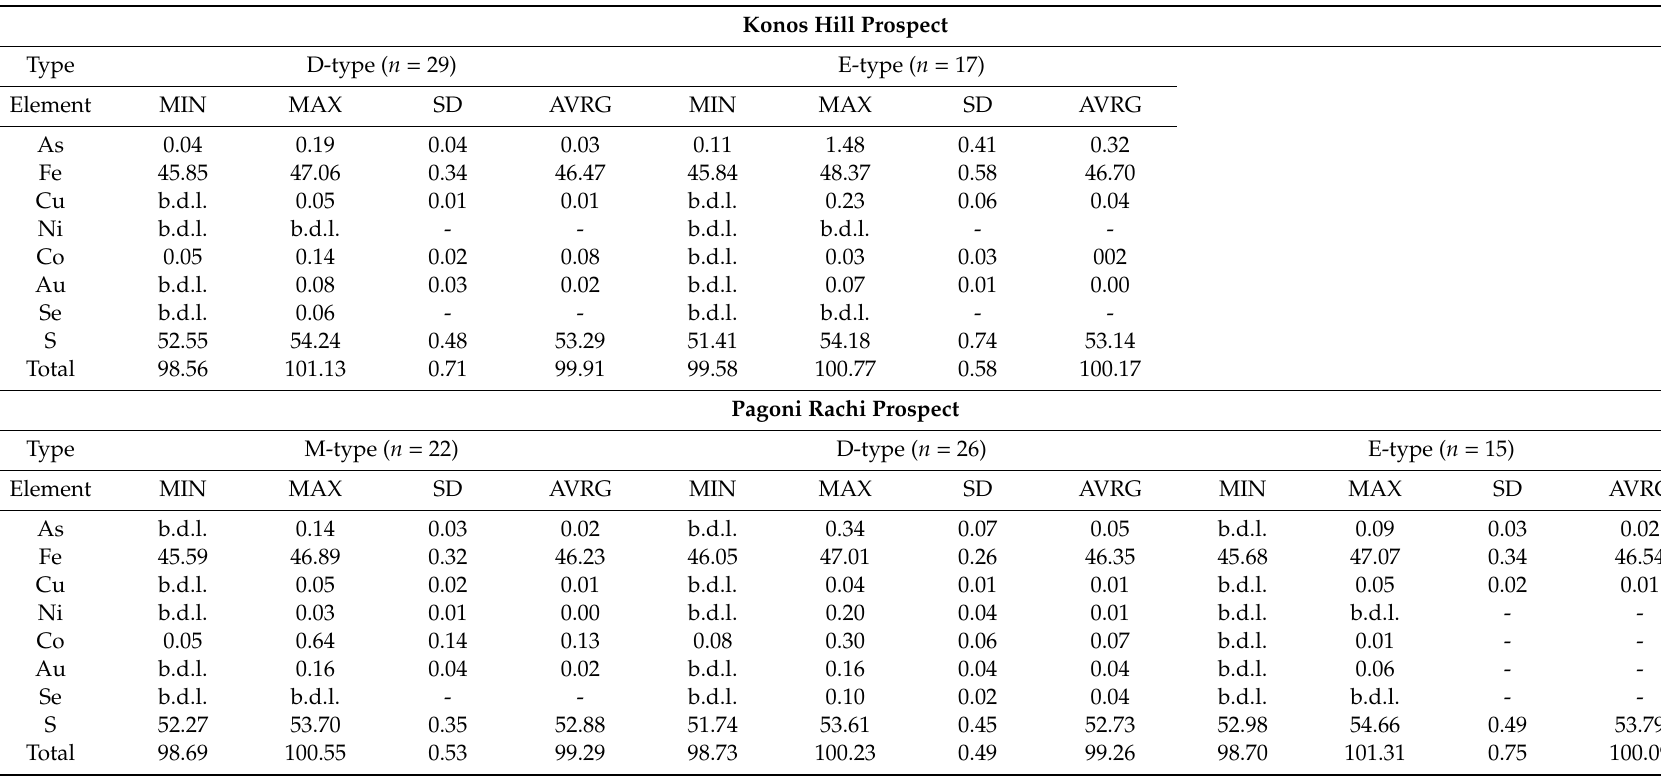
Table 2. EPM analyses of various pyrite generations from the Konos Hill and Pagoni Rachi porphyry / epithermal prospects. All values are reported in wt.%. For the full dataset please refer to supplementary Table